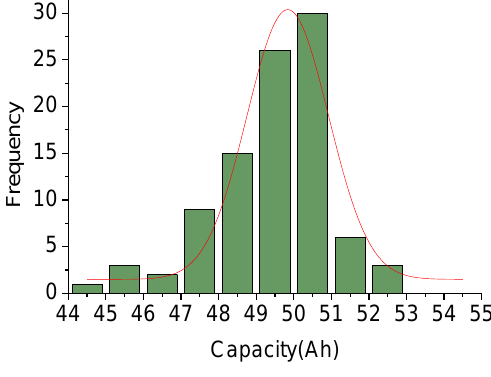
Figure 4. Battery capacity data.